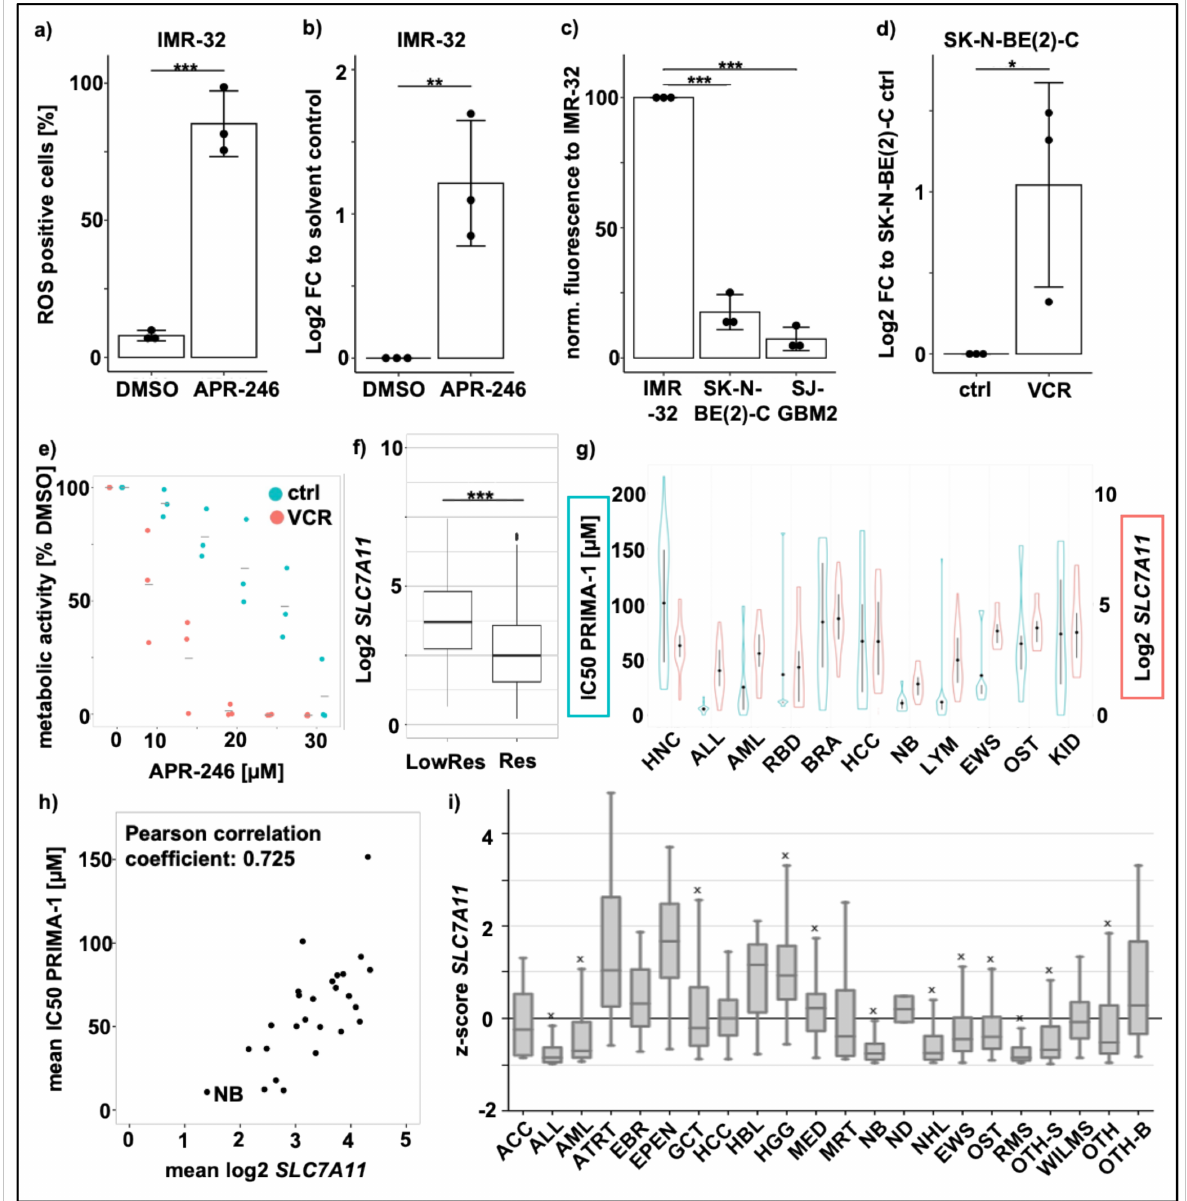
Figure 2. APR-246 response depends on the ROS levels. ( a ): The percentage of ROS positive IMR-32 cells after treatment with 50 µ M APR-246 for 5 h compared to solvent control (DMSO) detected after DCFDA staining by FACS; ( b ): Log2 fold change of BODIPY positive IMR-32 cells after treatment with 50 µ M APR-246 for 5 h compared to solvent control (DMSO) detected by FACS; ( c ): Basal ROS level in IMR-32, SK-N-BE(2)-C and SJ-GBM2 detected after DCFDA staining by FACS. Data were normalized to IMR-32 signal; ( d ): Log2 fold change of basal ROS level in vincristine resistant SK-N-BE(2)-C compared to control SK-N-BE(2)-C detected after DCFDA staining by FACS; ( e ): Metabolic activity measurement with CellTiter Glo-assay in vincristine resistant SK-N-BE(2)-C (red) and control SK-N-BE(2)-C (blue) after 72 h treatment with APR-246 0–30 µ M. Luminescence was normalized to the respective solvent control (DMSO); ( f ): Log2 SLC7A11 expression